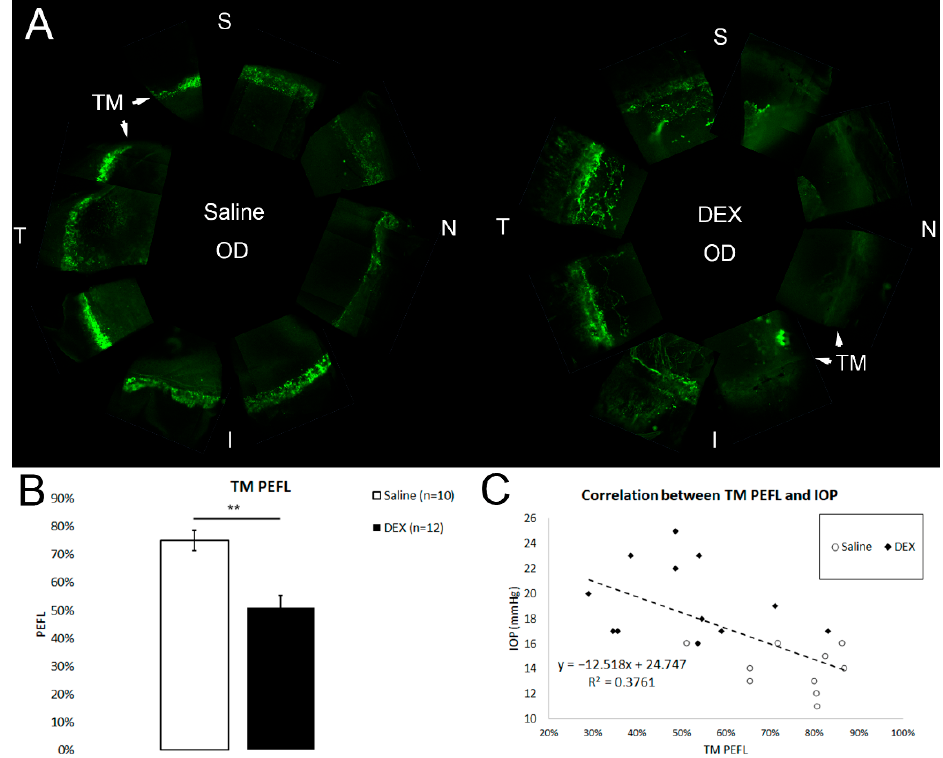
Figure 2. TM PEFL and its correlation with IOP. ( A ) Representative en face images of saline- and dexamethasone (DEX)-treated eyes (N: nasal; T: temporal; S: superior; I: inferior). The tracer distribution is shown in green. ( B ) DEX-treatment induced a significant reduction in trabecular meshwork percentage effective filtration length (TM PEFL) when compared to controls (**: p < 0.01). ( C ) There was a significant negative correlation between TM PEFL and IOP ( R 2 = 0.38, p = 0.002).